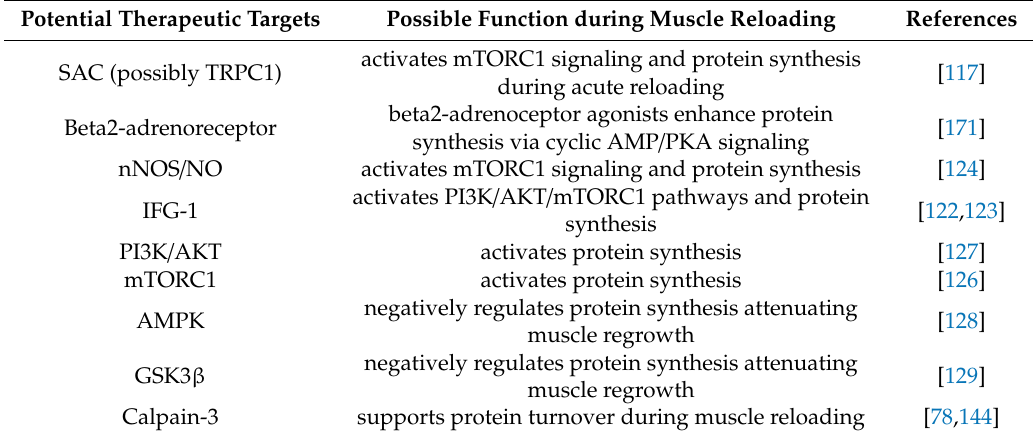
Table 3. Molecules that were shown to play an important role in the regulation of protein synthesis / turnover during muscle reloading and which may serve as potential therapeutic